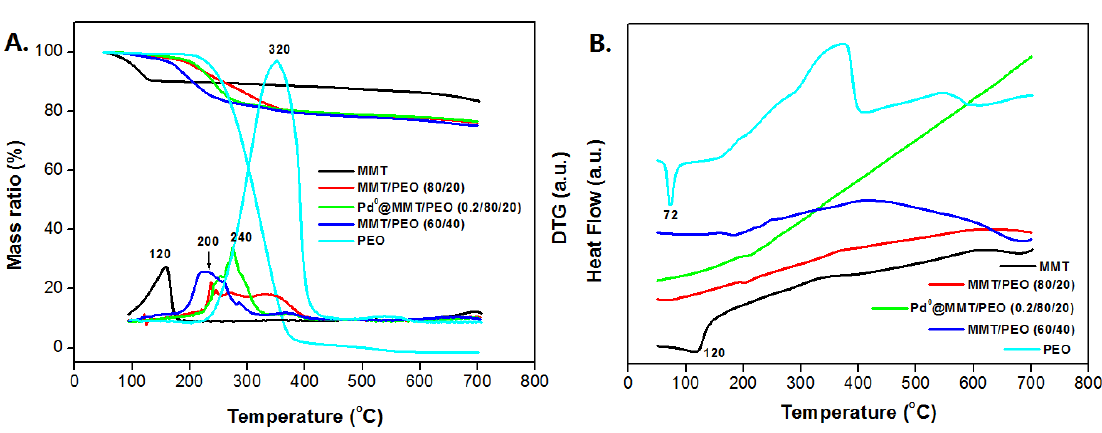
Table 3. Catalytic performances of Pd 0 @MMT/PEO for Heck reactions between aromatic halides with acrylates.